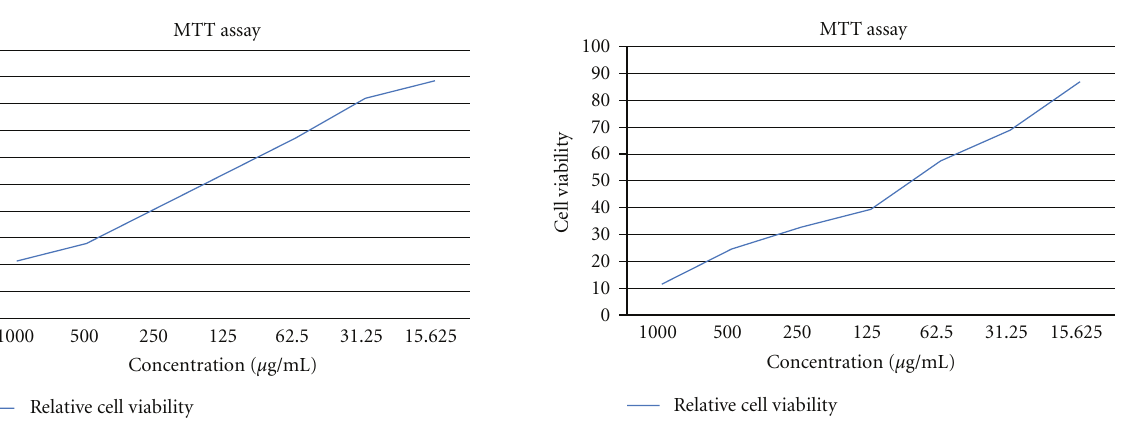
Figure 2: Relative cell viability of MCF-7 cells at di ff erent concen- tration of anthocyanin extracted by methanol.